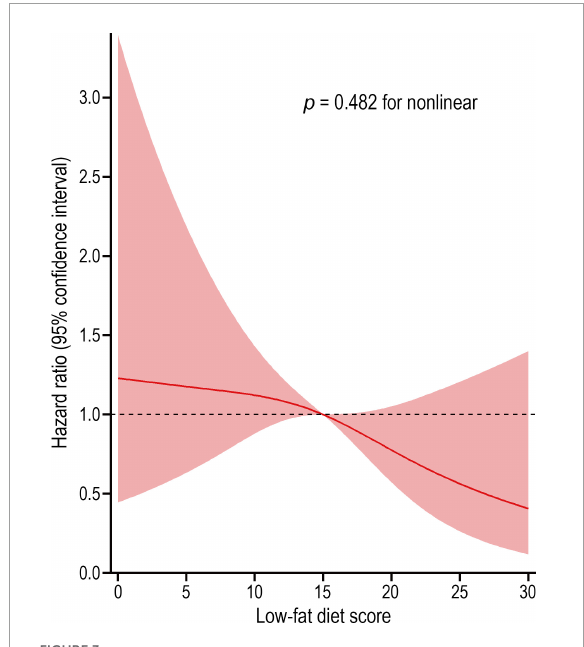
FIGURE3 Dose-response association between low-fat diet score and the risk of liver cancer. Hazard ratio was adjusted for age, sex, race, educational level, arm, body mass index, smoking status, smoking pack-years, drinking status, alcohol consumption, aspirin use, history of liver comorbidity, history of diabetes, physical activity level, and energy intake from diet ( p = 0.482 for